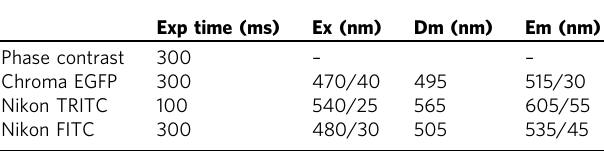
Table 2 Summary of the microscopy settings used in this